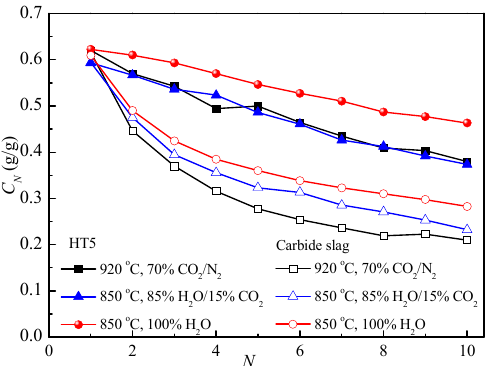
Figure 6. Effects of calcination conditions on the CO 2 capture capacities of HT5 (carbonation in 15% CO 2 / N 2 at 700 ◦ C for 20 min, calcination for 10 min).